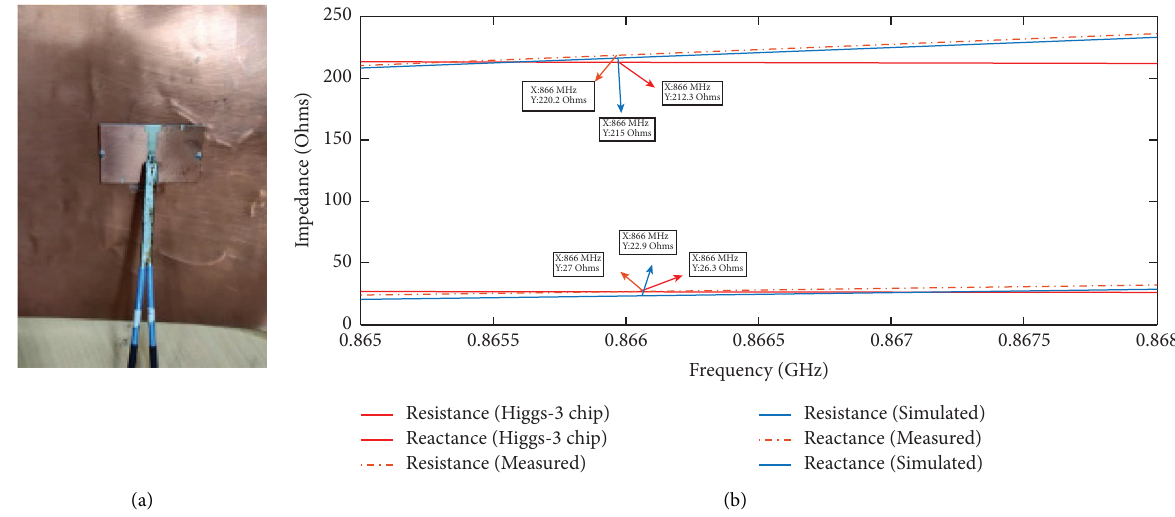
Figure 14: Simulated and measured impedance characteristics of the proposed tag (shown on left) on a metal sheet (200 × 200mm 2